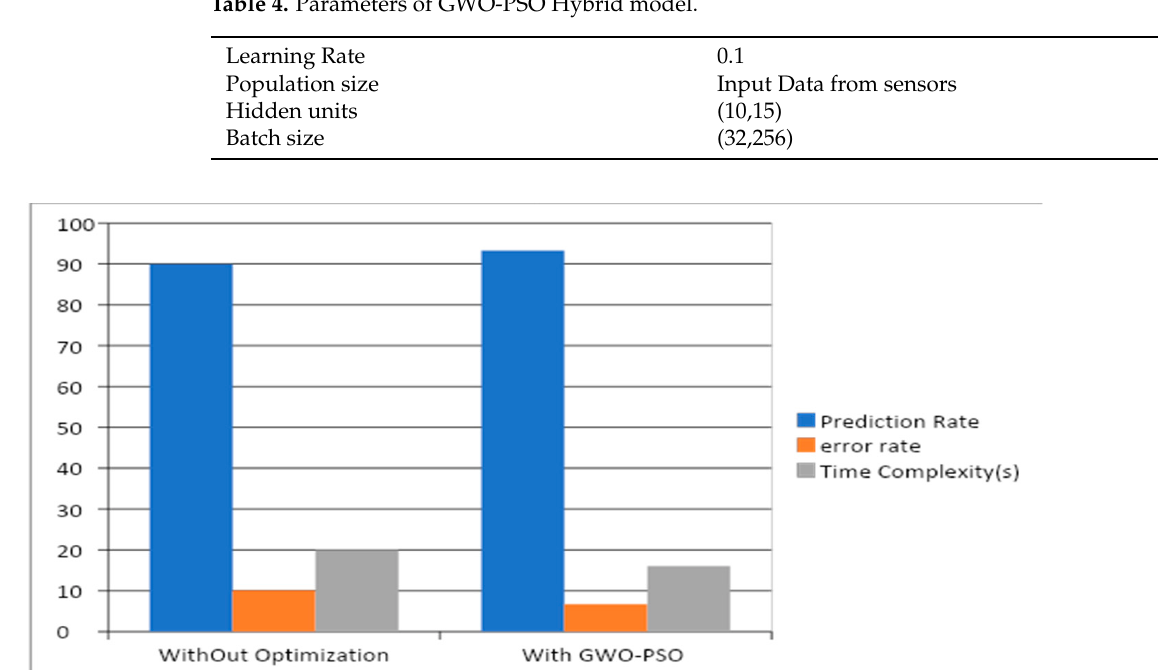
Figure 5. Comparison between before after optimizing the BGF-CNN model.